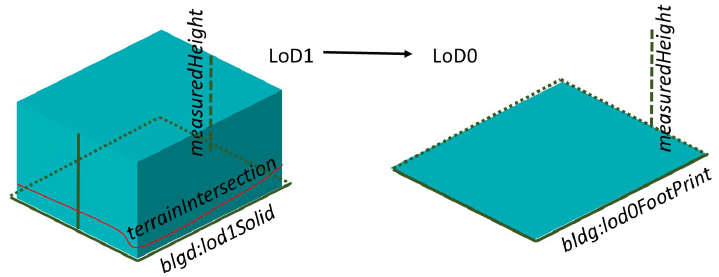
Figure 8. An overview of downscaling LoD1 models to